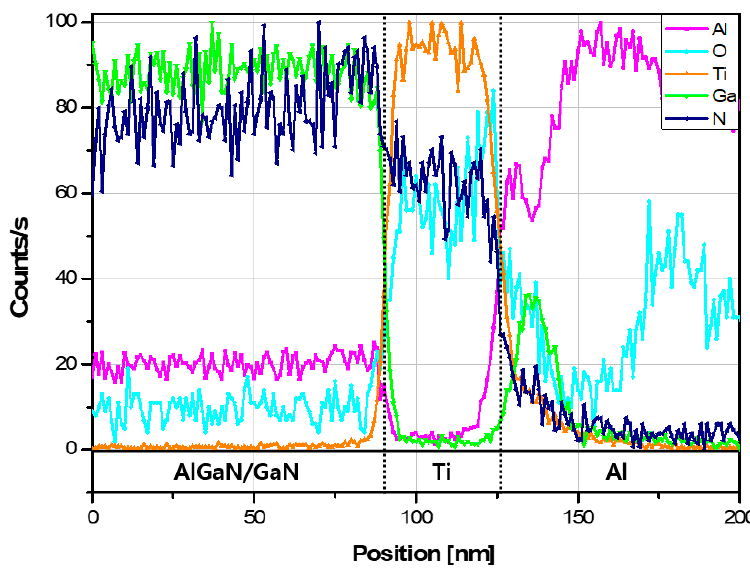
Figure 10. Elemental content in each position in strongly annealed area 2.